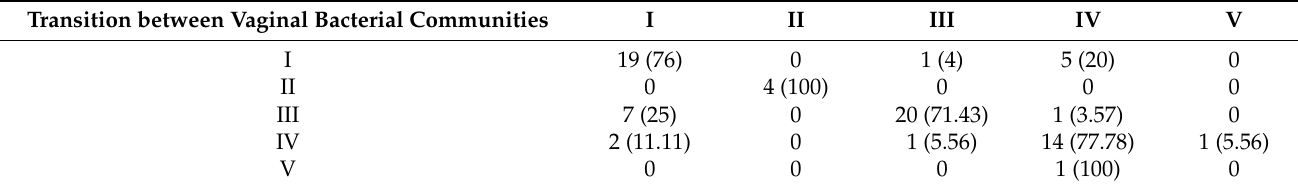
Table 1. Transition between vaginal bacterial communities, n (%). Transition between Vaginal Bacterial